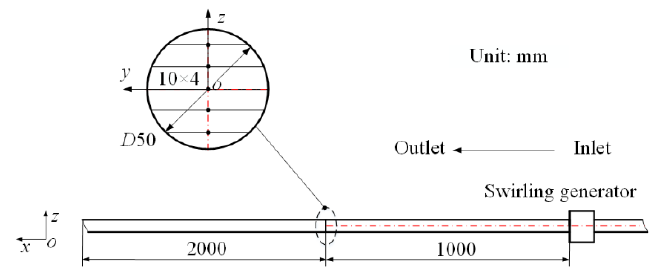
Figure 5. Schematic of experimental measuring domain.